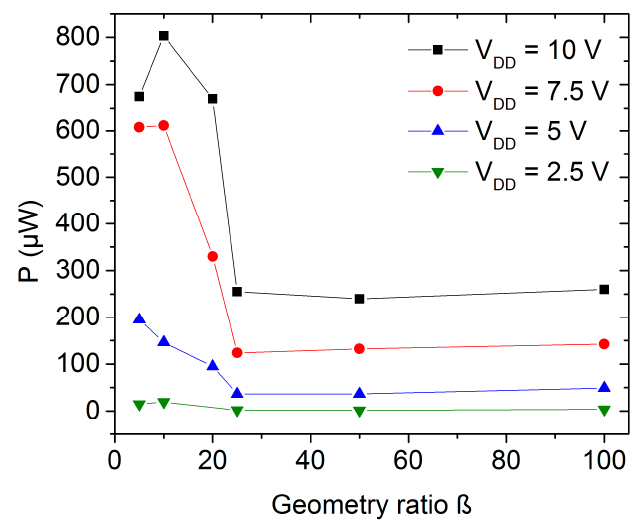
Figure 11. Power consumption as function of the ZnO nanoparticle inverter geometry ratio.